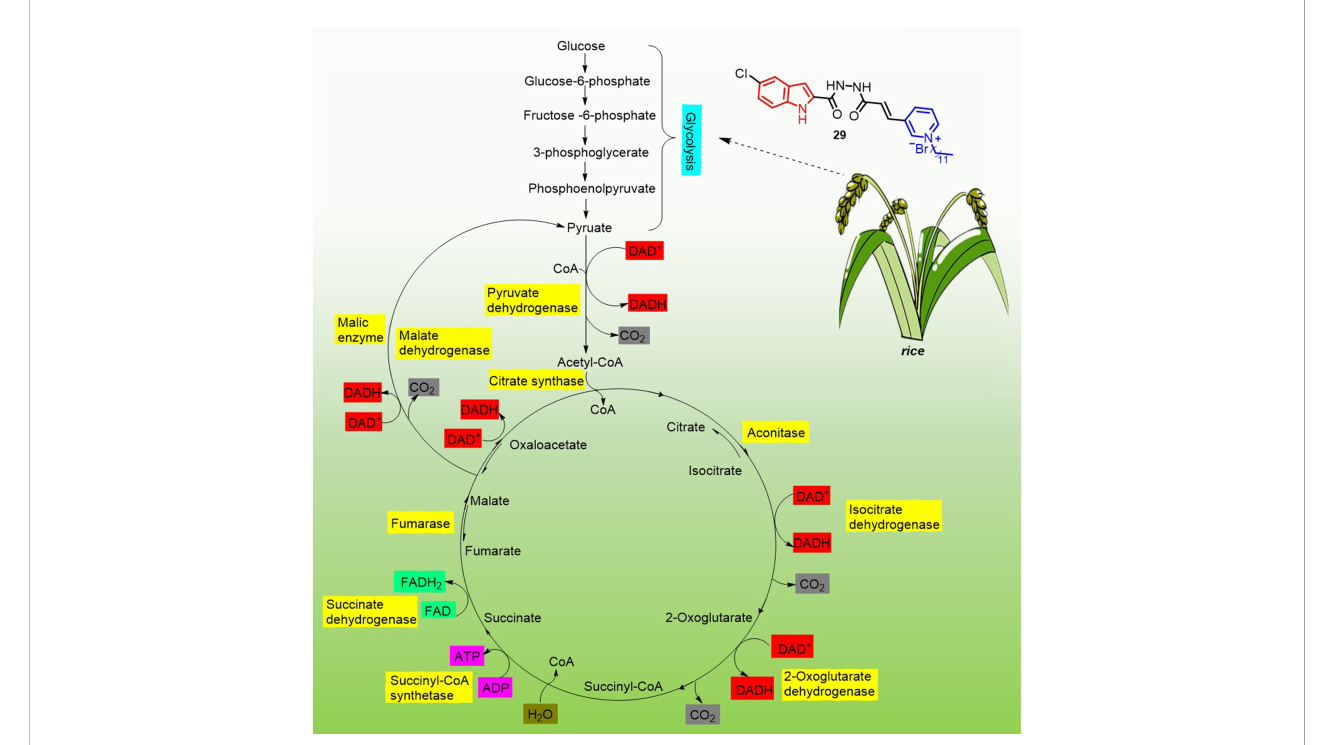
FIGURE 8 Mechanism of disease resistance triggered by compound 29 stimulation in rice .